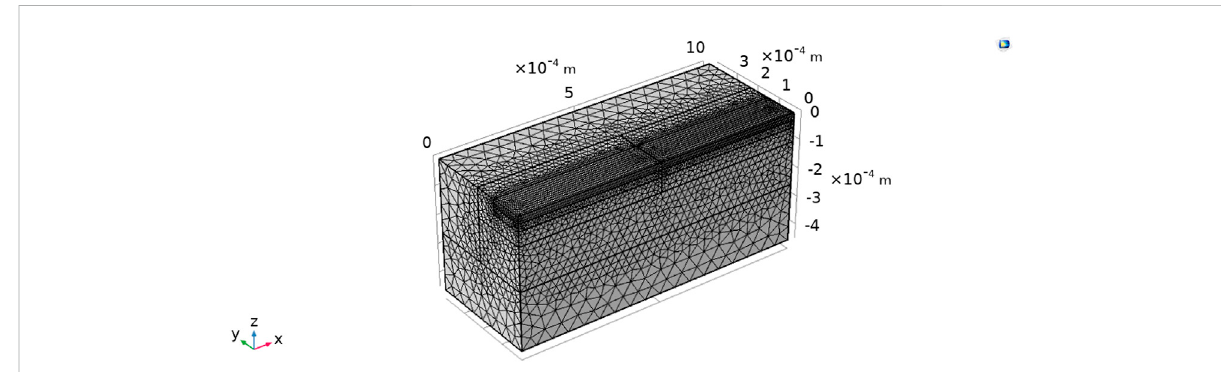
FIGURE 2 Meshed Bi 2 Te 3 geometry used in our simulations.